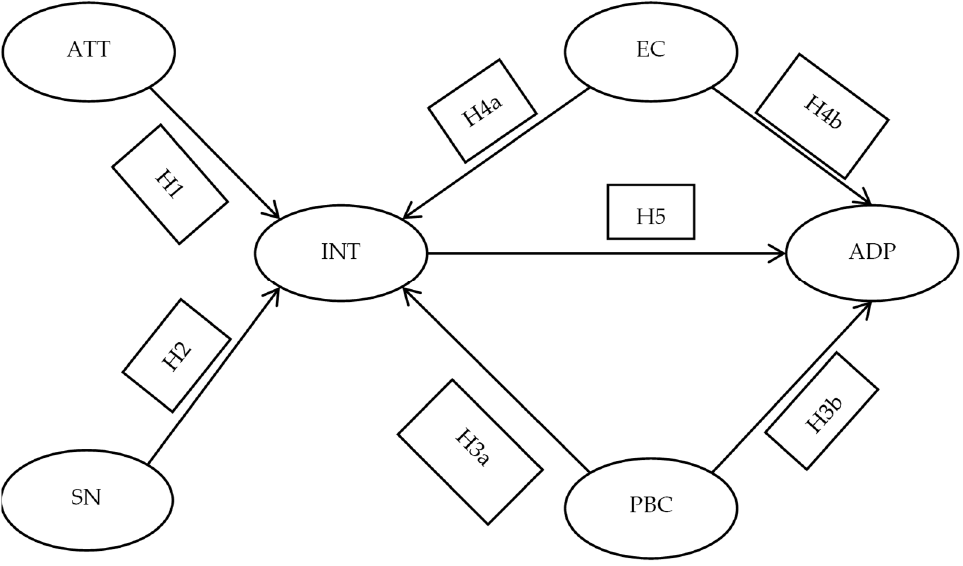
Figure 1. Research framework for the study.